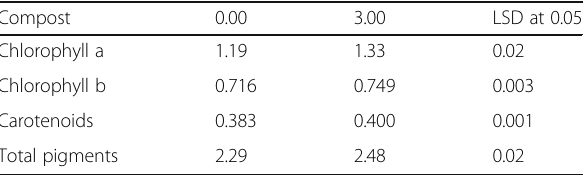
Table 8 Effect of compost addition to soil (0.00 and 3.0 tons/ fed) on photosynthetic pigments ( μ g/g fresh wt) of flax leaves under sandy soil